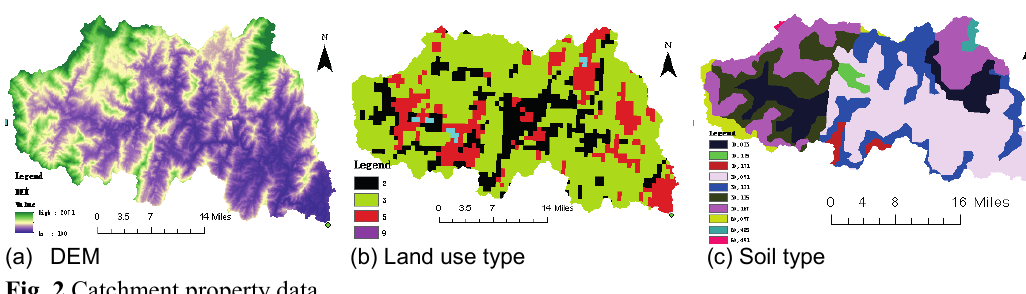
Fig. 2 Catchment property